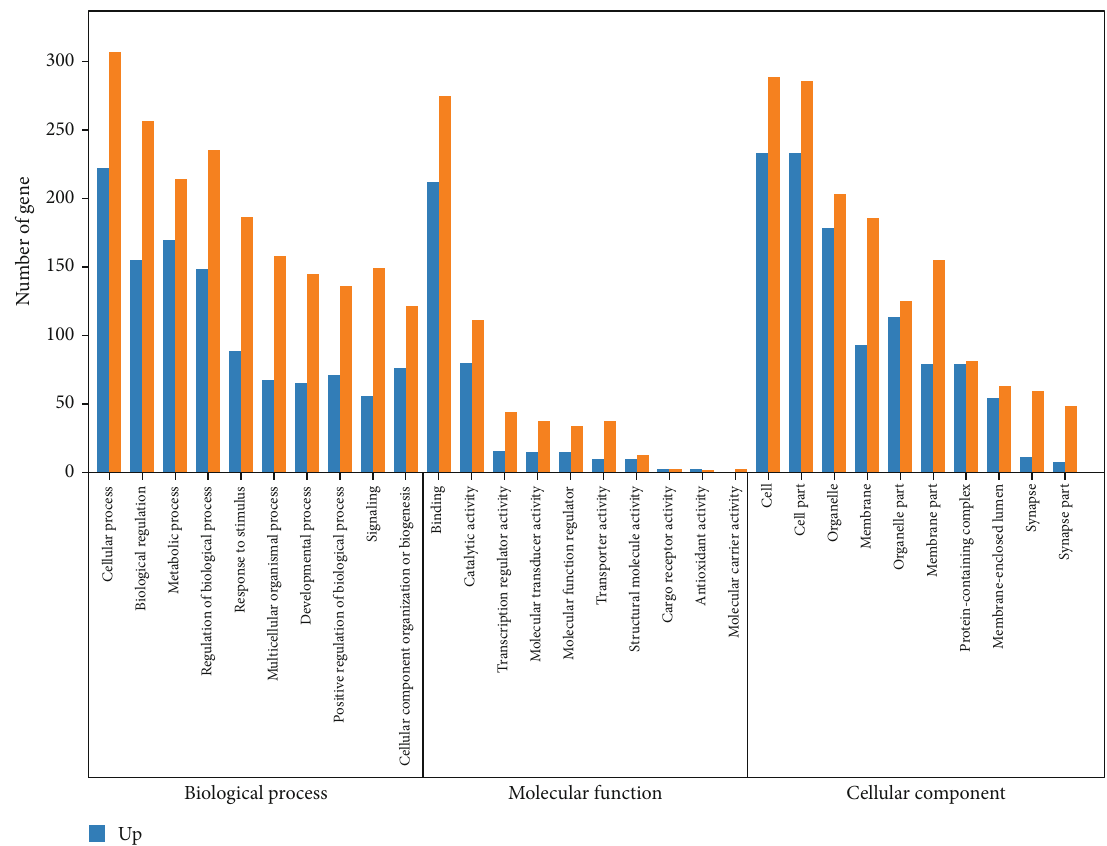
Figure 6: Gene ontology enrichment analysis of DEGs. The ordinate is the number of genes, the abscissa is the GO name. Blue refers to the upregulated genes; orange refers to the downregulated genes.